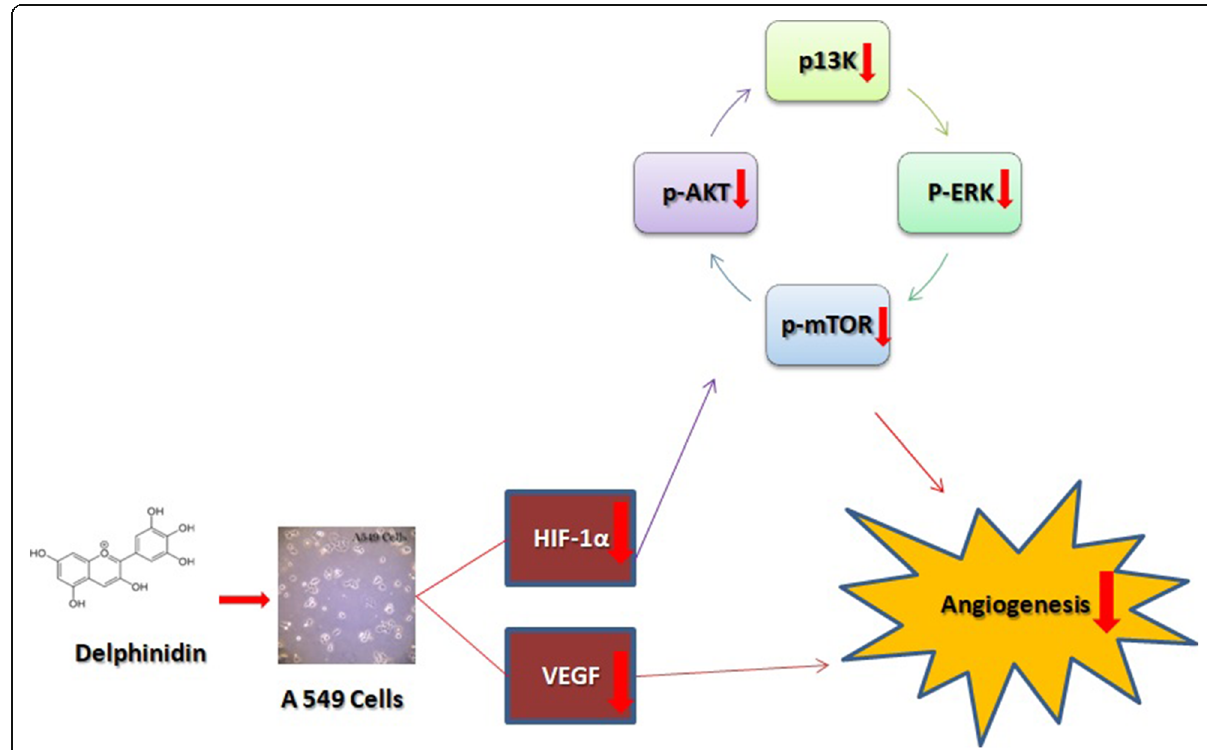
Fig. 6 A representation describing the molecular mechanism of delphinidin on the antiangiogenic activity in A 549